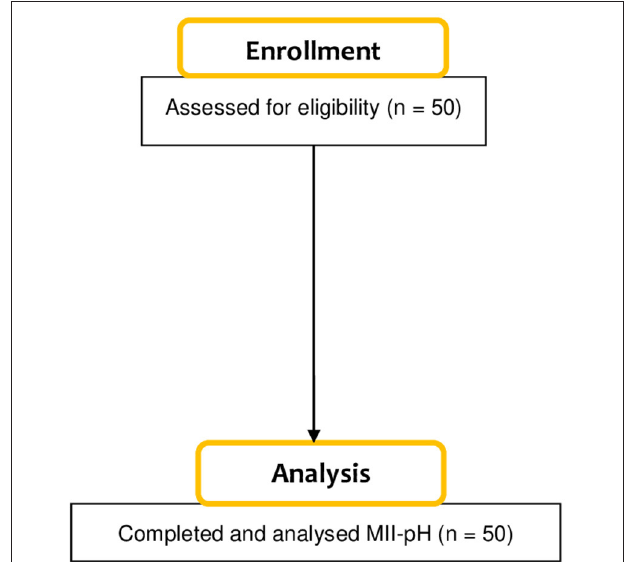
FIGURE 1 | Recruitment of study participants.